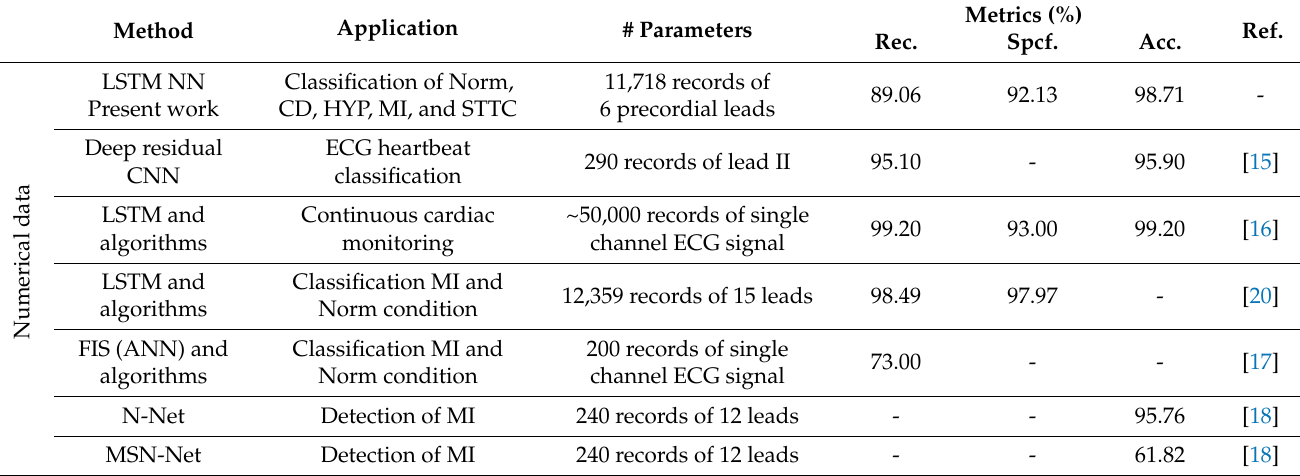
Table 6. Different methods of using numerical and image data present in the